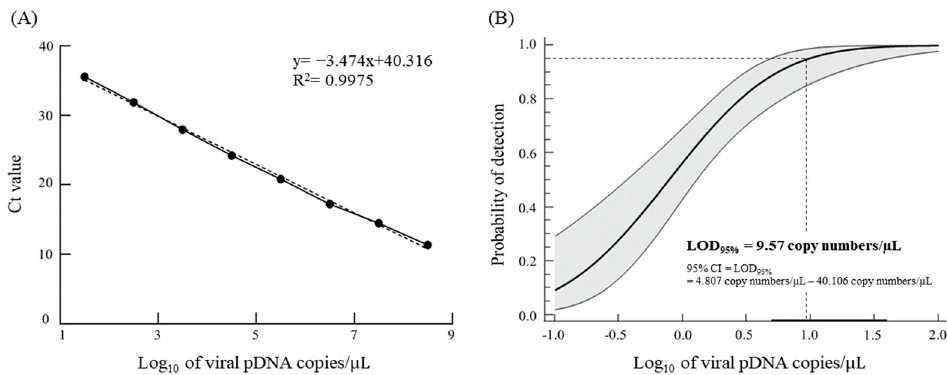
Figure 1. Quantification of viral cDNA was performed by VHSV specific qRT-PCR using primers and a TaqMan probe, and the cut-off value was set based on LOD 95% . ( A ) Standard curve indicating a linear relationship between Ct (cycle number of threshold) values and the serial ten-fold pDNA (3.17 × 10 1 to 3.17 × 10 8 copies/ μ L) containing the N gene fragment. ( B ) The probability of detection (POD) curve was indicated with a solid line, and a 95% confidence interval was highlighted as the gray zone. LOD 95% (9.57 viral pDNA copies/ μ L) was denoted using a dotted line.